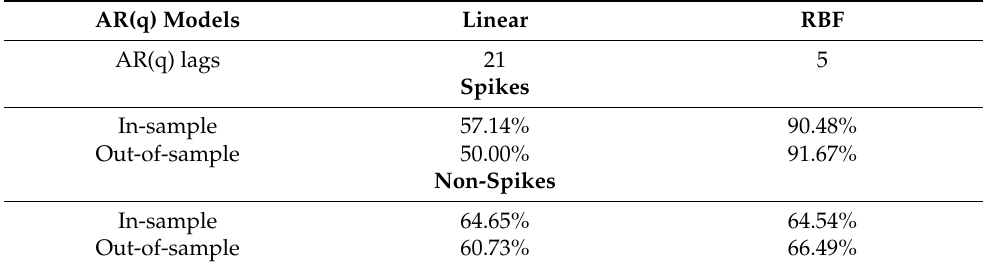
Table 4. AR models, per-class